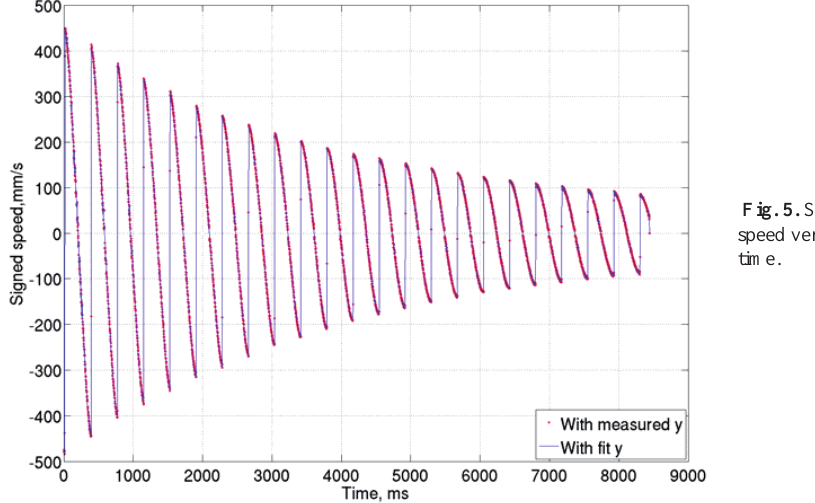
Fig. 5. Signed speed versus time.